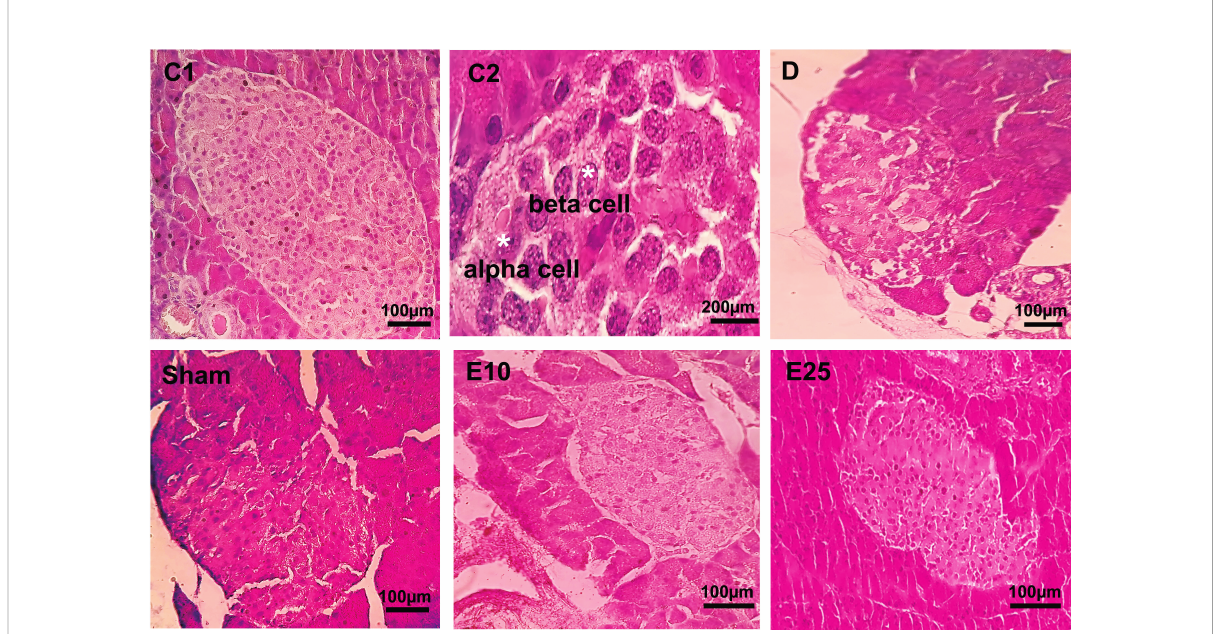
FIGURE 4 Pancreas cross-section. C1: control rats (magni fi cation x400), C2: control rats (magni fi cation x1000), D: diabetes group, sham: diabetic rats that received distilled water for 8 weeks, E10: empagli fl ozin-10 group (diabetic rats that received 10 mg/kg/day empagli fl ozin for 8 weeks, E25: empagli fl ozin-25 group (diabetic rats that received 25 mg/kg/day empagli fl ozin for 8 weeks. Magni fi cation of D, sham, E10, and E25: x400.